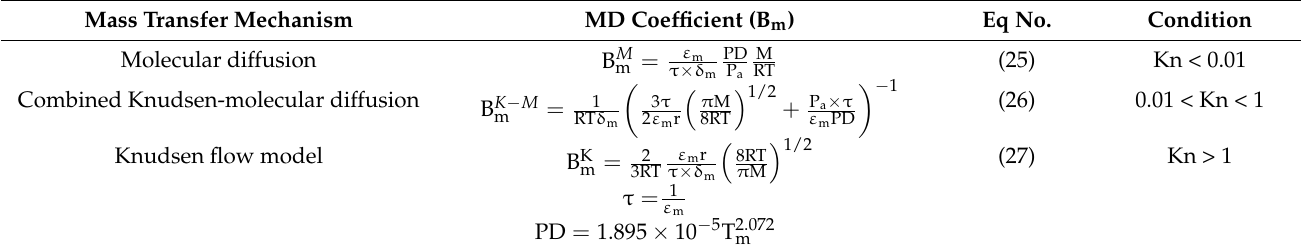
Table 1. Estimation of membrane distillation coefficient (B m ) in DCMD [17,20].